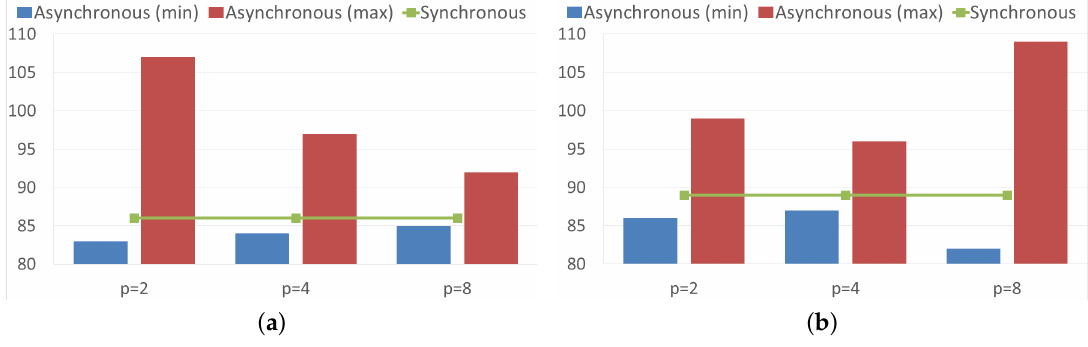
Figure 1. Comparison of convergence rates of the synchronous Power method versus the asynchronous version, SM, α = 0.85, (cid:101) = 10 − 8 . ( a ) Number of iterations, uk-2002. ( b ) Number of iterations,